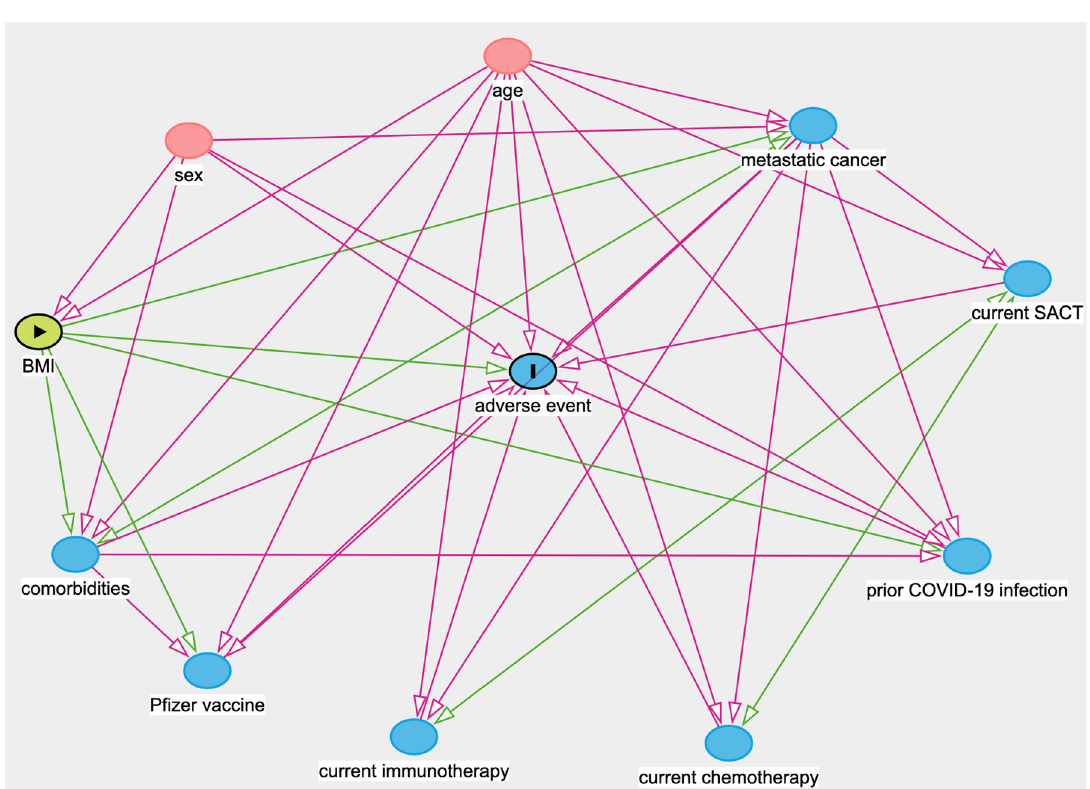
Figure A1. Directed Acyclic Graph (DAG) for the association between patient and oncological characteristics and risk of developing COVID-19 vaccine-related adverse events (www.dagitty.net, accessed on 17 May 2021). In this figure, BMI is used as an example of exposure variable with adverse event as the outcome. Green lines represent causal path; Pink lines represent biasing path.